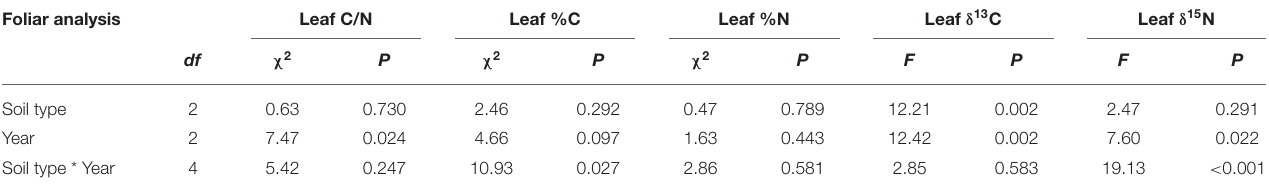
TABLE 3 | Results from the mixed model analysis of variance for leaf carbon to nitrogen ratios (C/N), 13 C discrimination ( δ 13 C), and 15 N discrimination ( δ 15 N). Foliar analysis